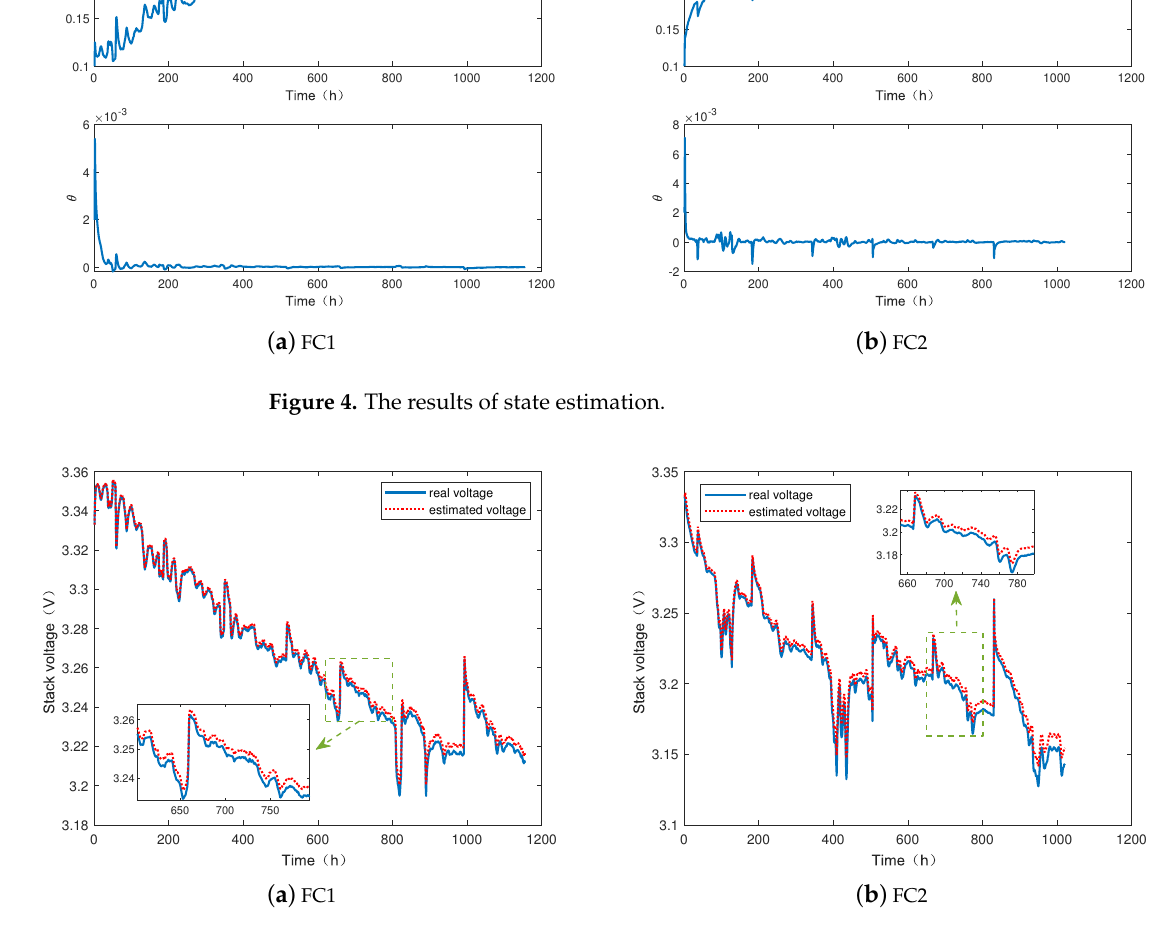
Figure 5. The fitting voltage